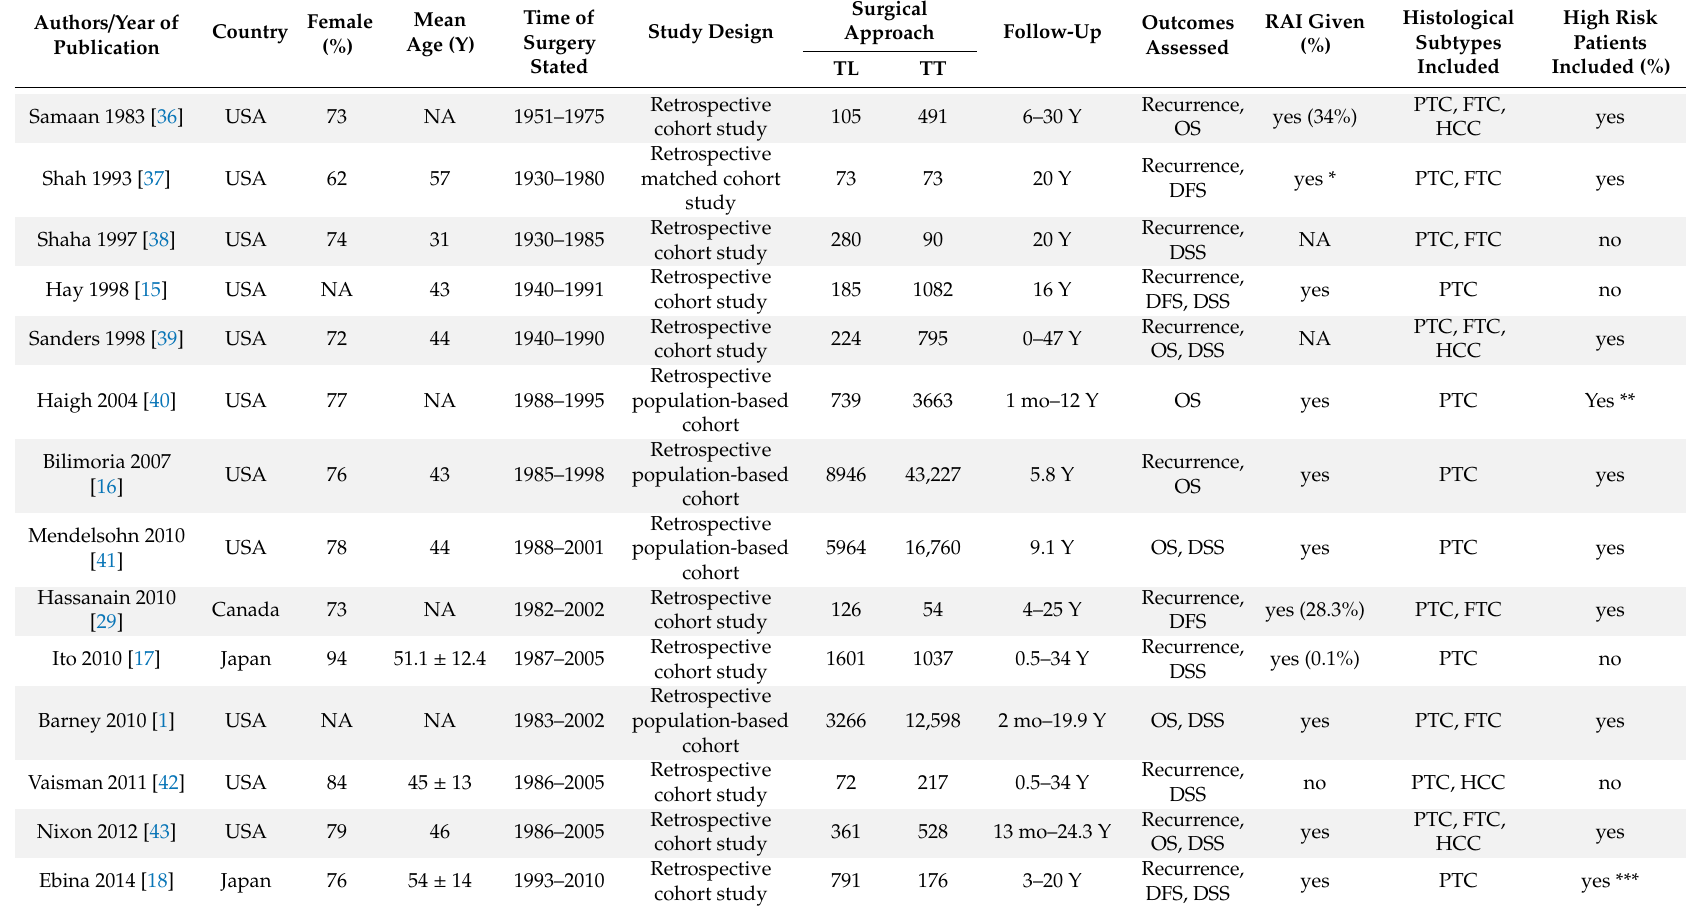
Table 1. Characteristics of the selected studies included in the